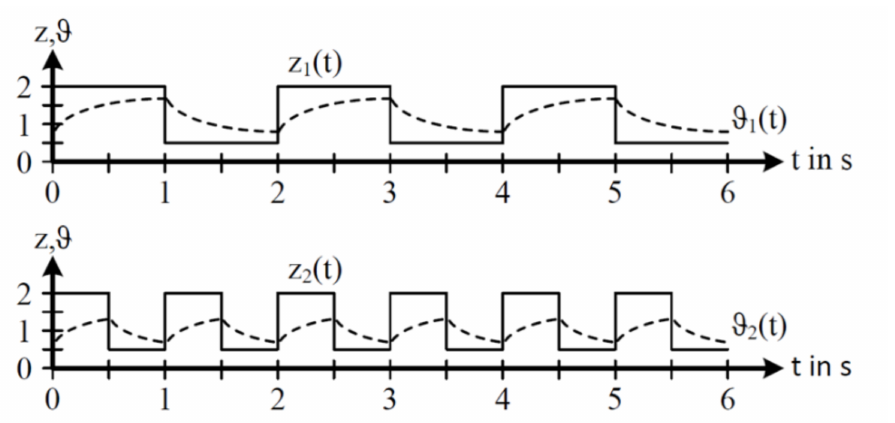
Figure 4. Comparison of two statistically equal loads. Modified from [9], Technische Universität Dresden,